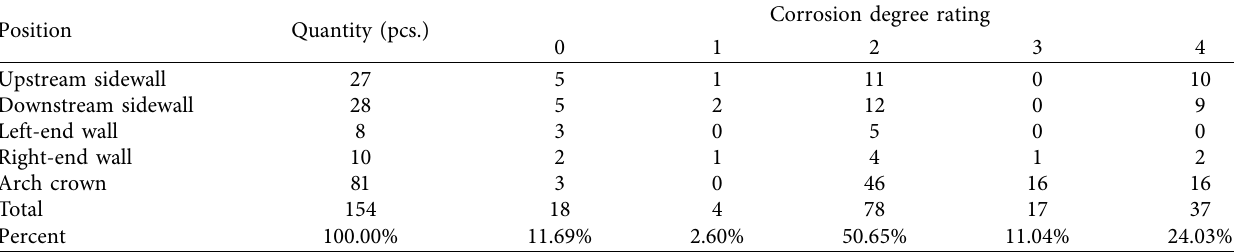
Table 10: Corrosion ratings of anchor head structure.